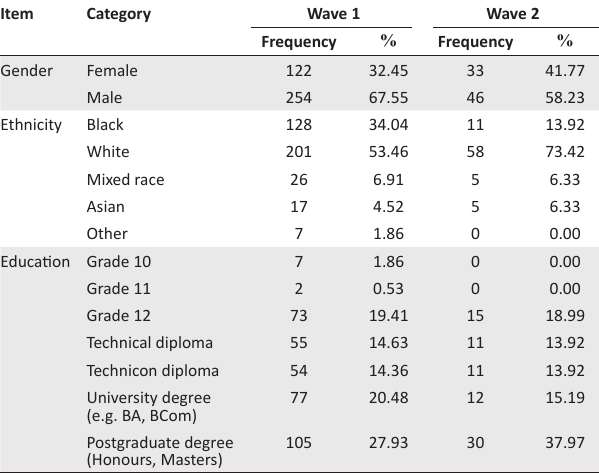
TABLE 1: Characteristics of the participants. Item